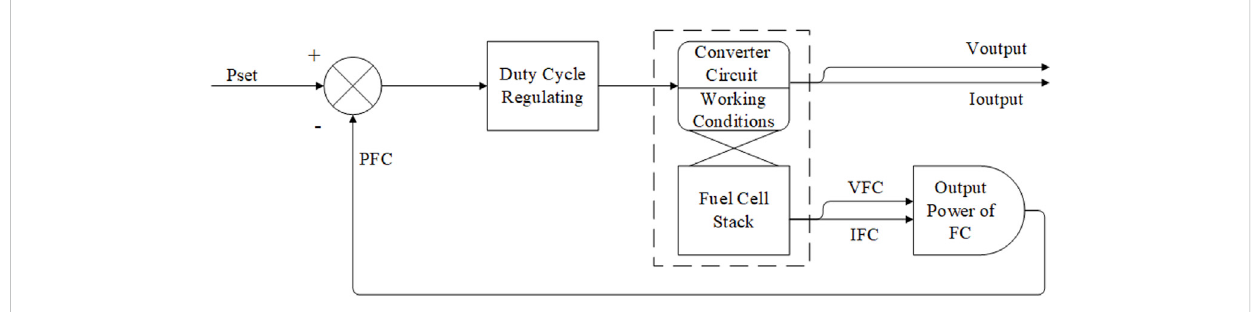
Working procedure of fuel cell output power regulation